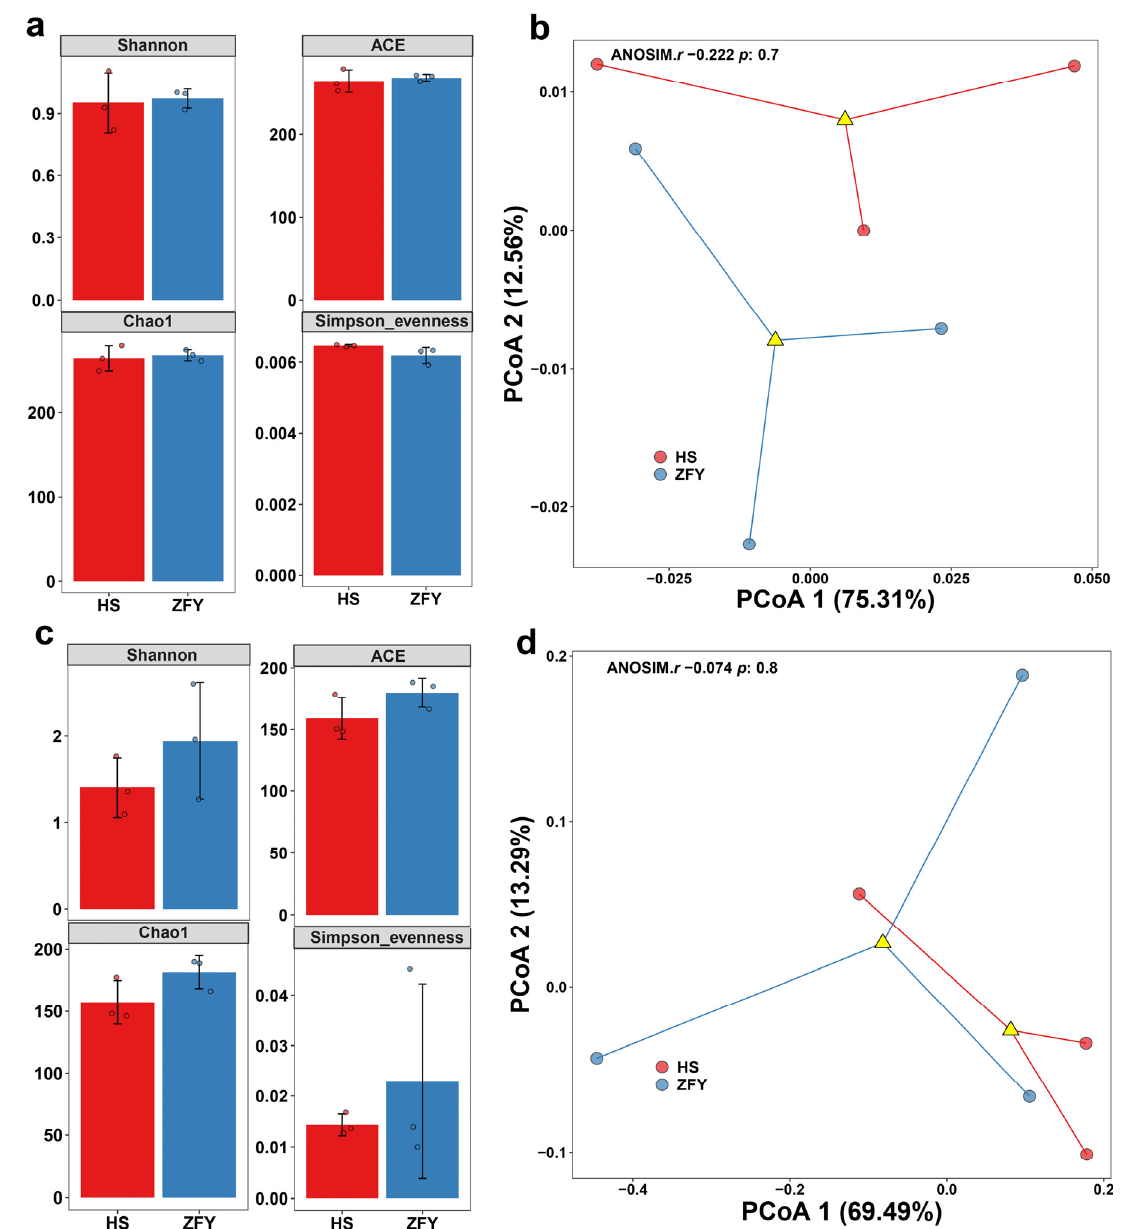
Figure 1. Alpha and beta analyses of endophytic microorganisms in HS and ZFY roots. Shannon diversity, ACE estimator, Chao1 estimator, and Simpson index of the bacterial communities ( a ) and fungal communities ( b ). Principal coordinate analysis (PCoA) of the bacterial communities ( c ) and fungal communities ( d ).